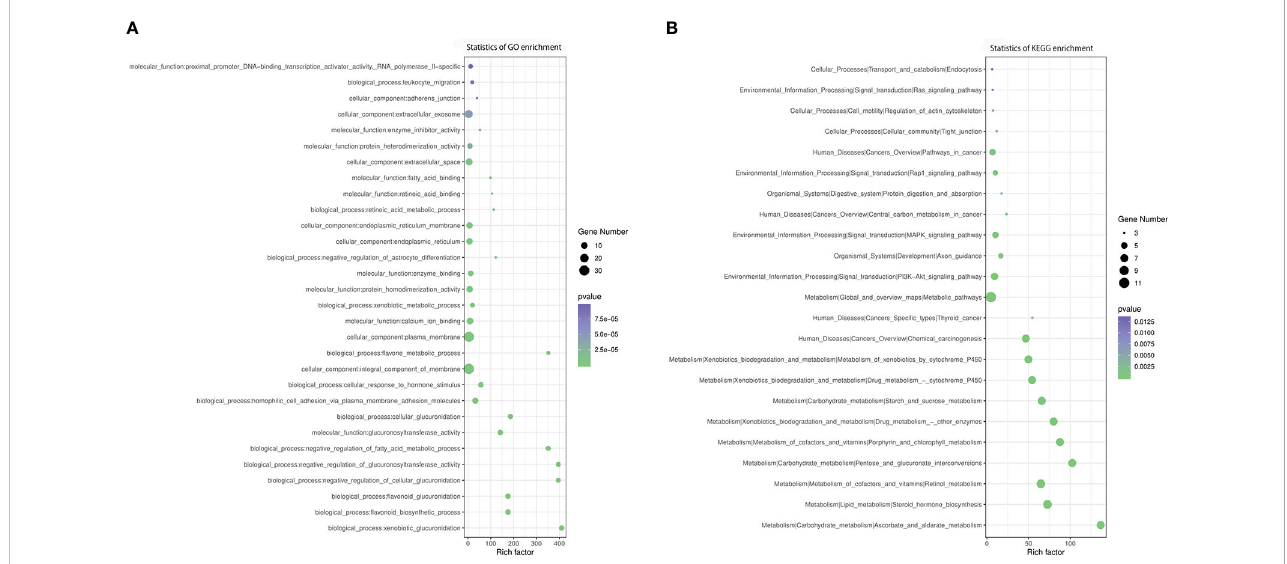
FIGURE 7 GO and KEGG enrichment analysis of DMR-related DEGs. (A) GO analysis of DMR-related DEGs. (B) KEGG analysis of DMR-related